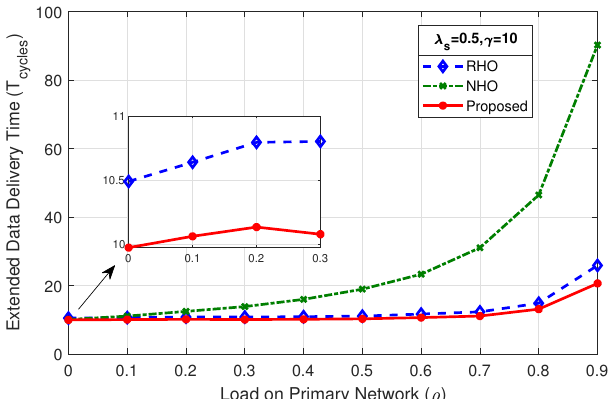
Figure 11. Comparison of mean EDDT for λ s = 0.5, γ =